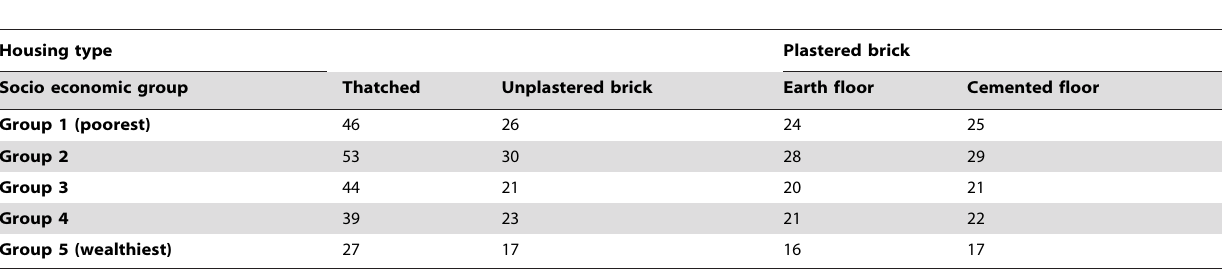
Table 4. Total Phlebotomus argentipes counts by socio economic group and type of housing predicted by the multivariate model for a village with average vector